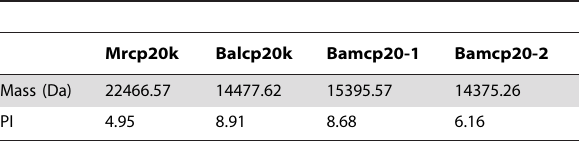
Table 2. Mass and PI of the homologues of cp20k from three barnacle